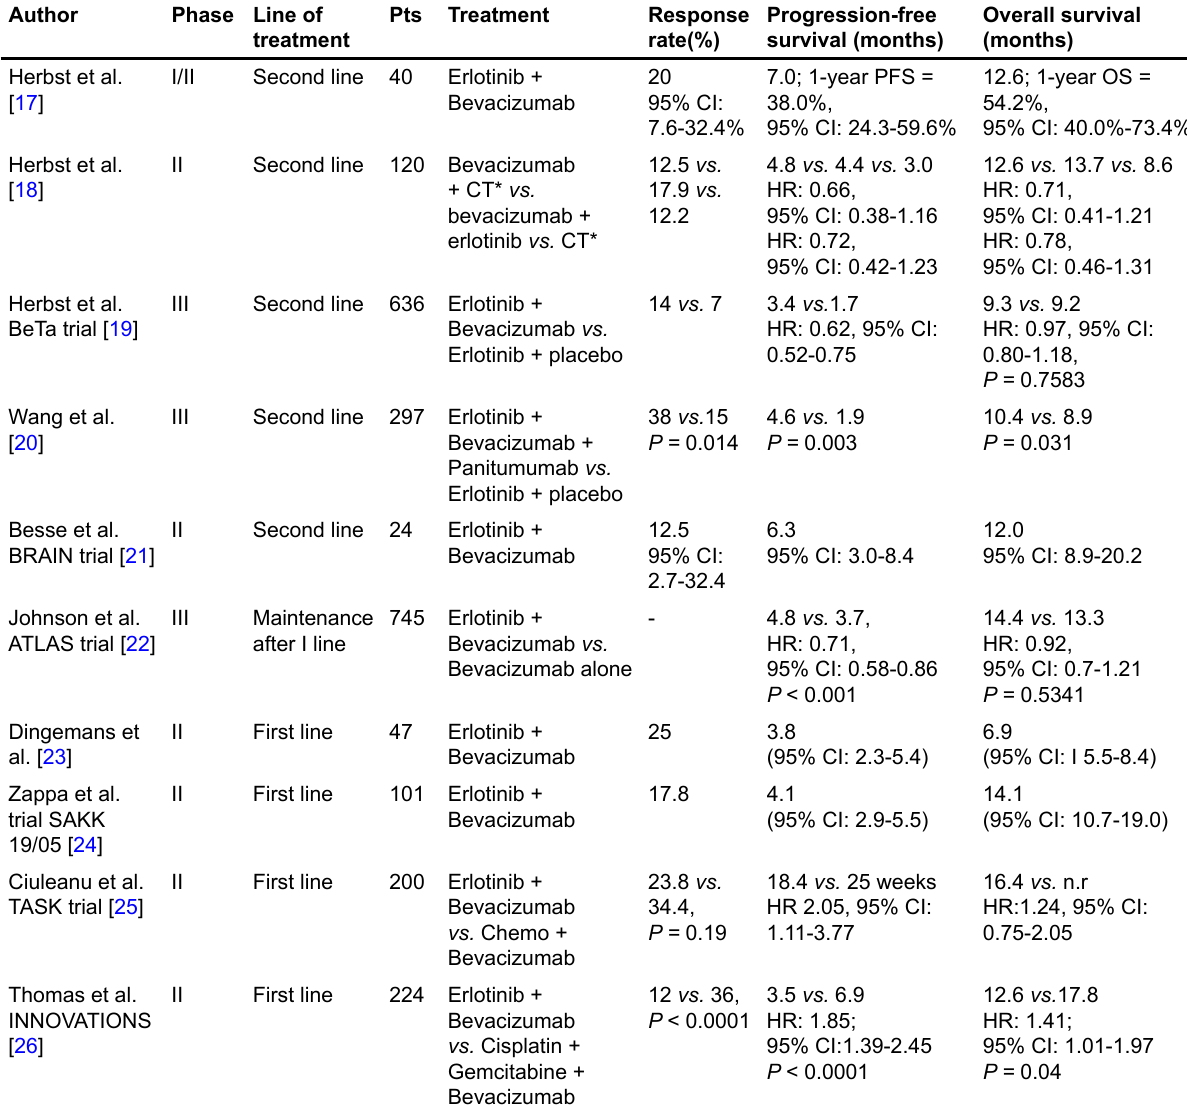
Table 1. Bevacizumab and erlotinib in EGFR wild type NSCLC